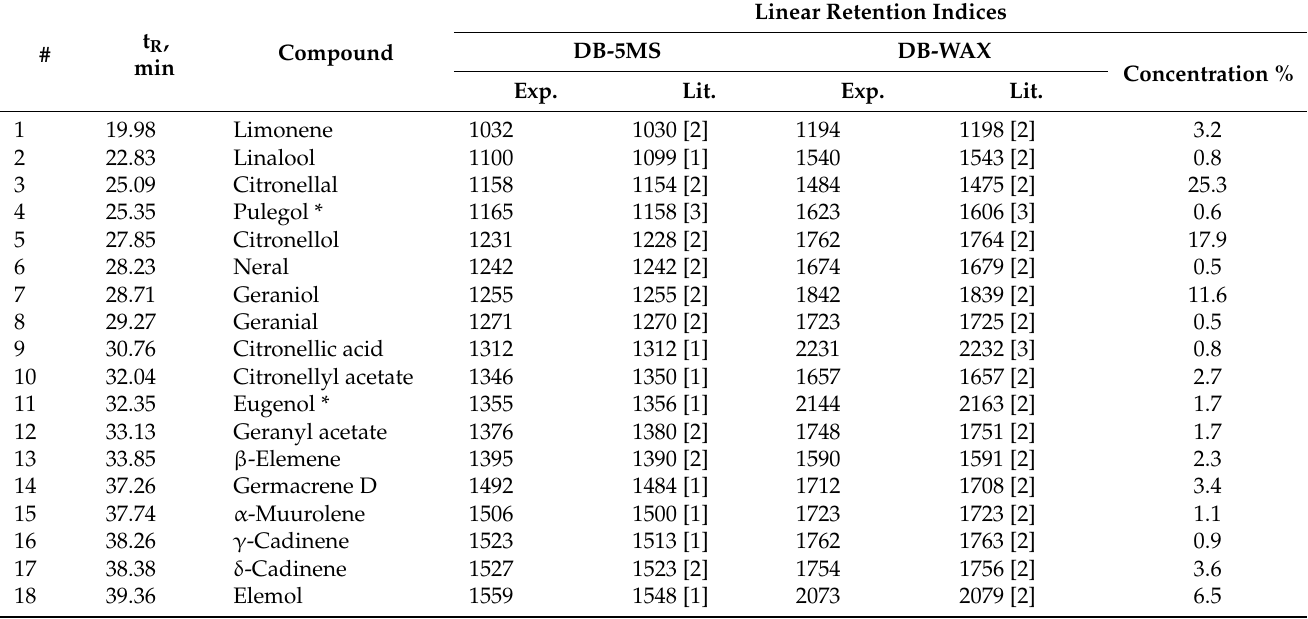
Table 1. Chemical composition of citronella EO obtained by